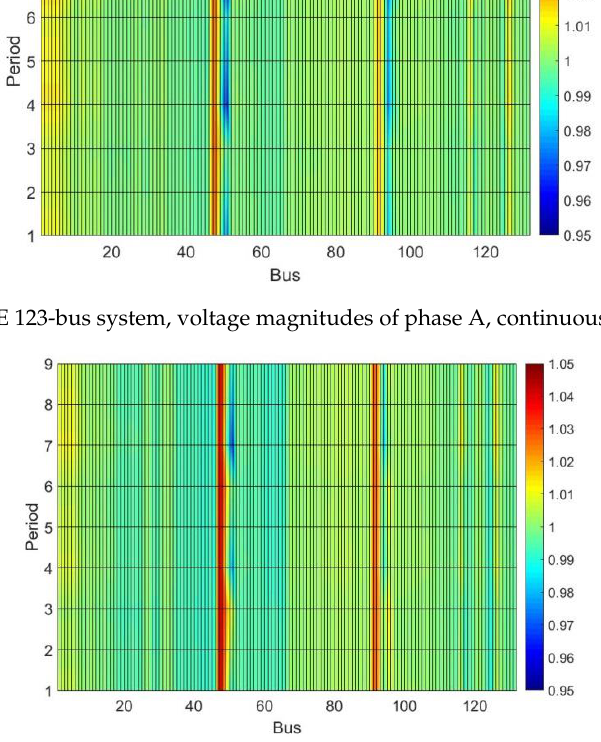
Figure 11. IEEE 123-bus system, voltage magnitudes of phase A, discrete taps, 20% PV.